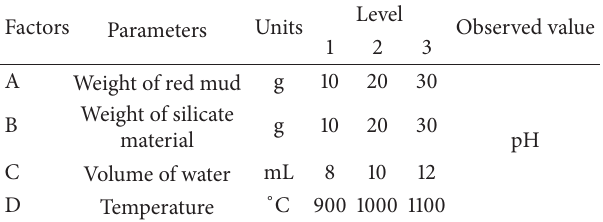
Table 1: Experimental layout of parameters and their